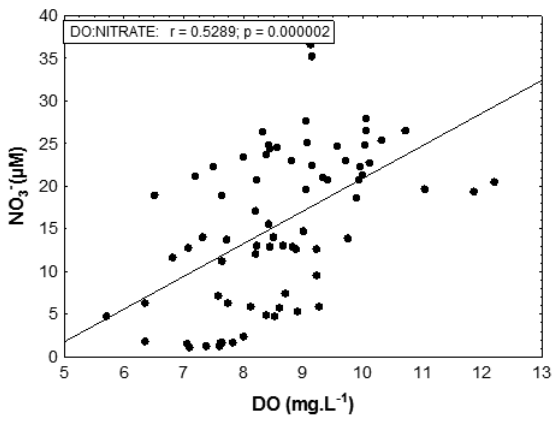
Figure 4 - Plot of concentration of dissolved oxygen (DO mg.L -1 ) and nitrate (NO 3- ) of streamwater collected at undisturbed (1, 2, 3, 4, 5, 6) and disturbed sites (7, 8, 9, 10).